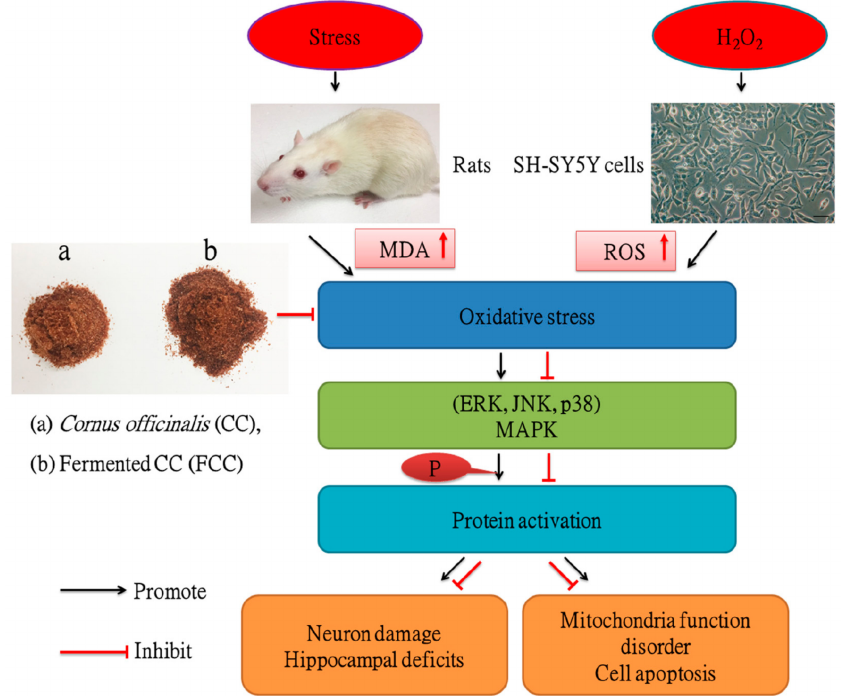
Figure 8. A schematic diagram illustrating the protective mechanism of Cornus o ffi cinalis (CC) and fermented CC extract against oxidative stress. CC and FCC extracts decreased the MDA and ROS levels in rats and cells, suppressed the MAPK phosphorylation to inhibit stress-induced hippocampal deficits and H 2 O 2 -induced oxidative